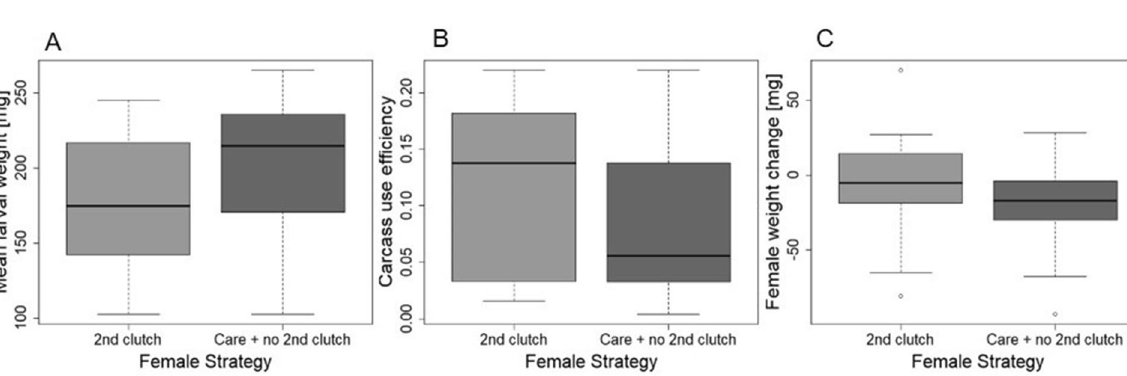
Figure 3. ( A ) Mean larval weight, ( B ) carcass use efficiency (total brood mass/carcass mass), and ( C ) body weight change during breeding of those females that did not produce a second clutch but continued to care for the initial brood and those females that produced a second